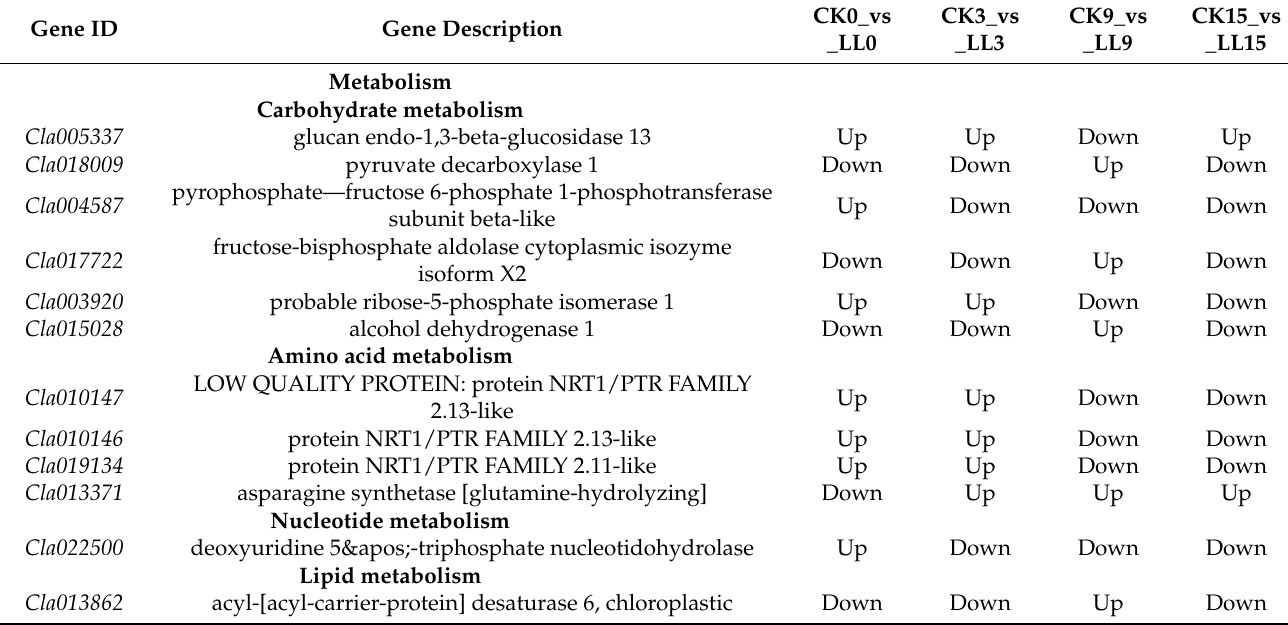
Table 2. 55 DEGs that were shared at all four time